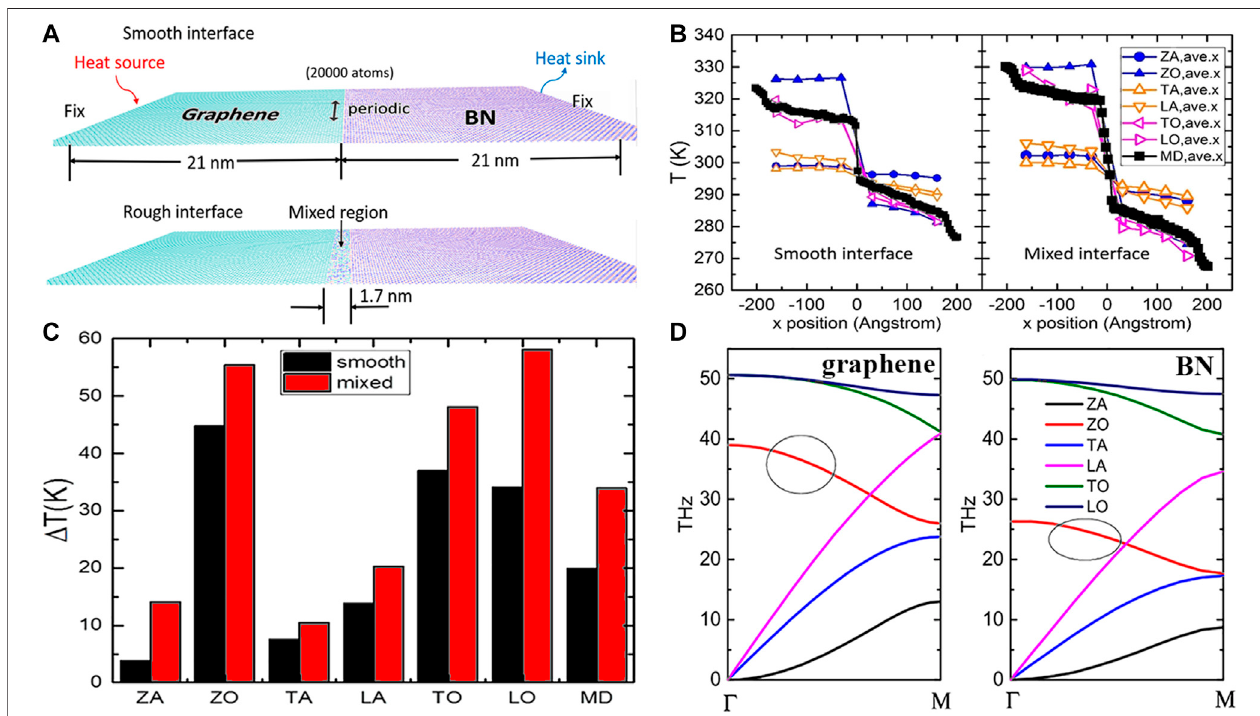
FIGURE 3 | (A) NEMD simulation setups for graphene/h-BN with smooth/rough interfaces, (B) The overall temperature pro fi le in NEMD and the spectral phonon temperatures for the six branches, (C) The phonon branch temperature jumps, (D) The phonon dispersion relations of graphene and h-BN. Note that the ZO branches have negligible frequency overlap. Reproduced from (Feng et al., 2017) with permission from American Chemical Society.